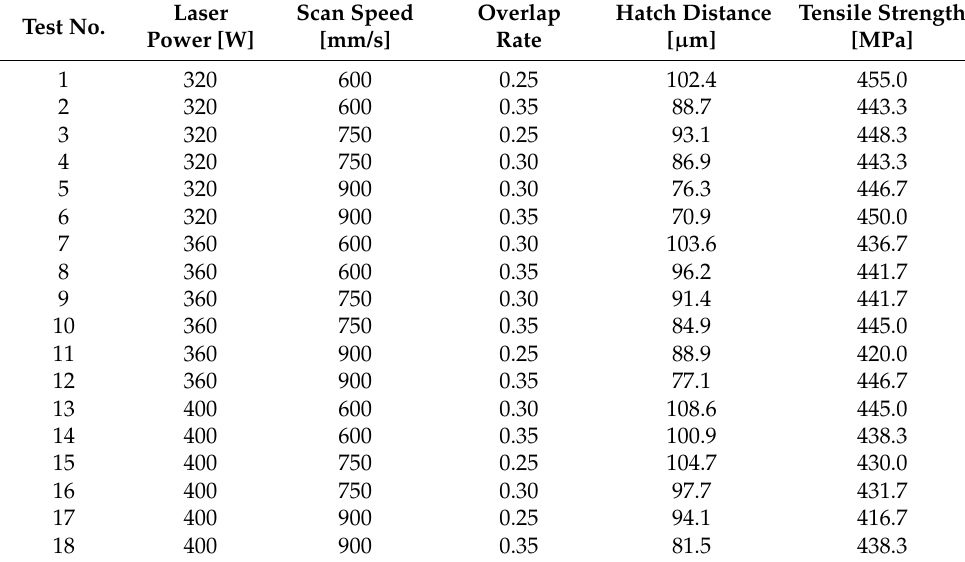
Table 5. Data for modeling tensile strength of the multiple layer samples. Test